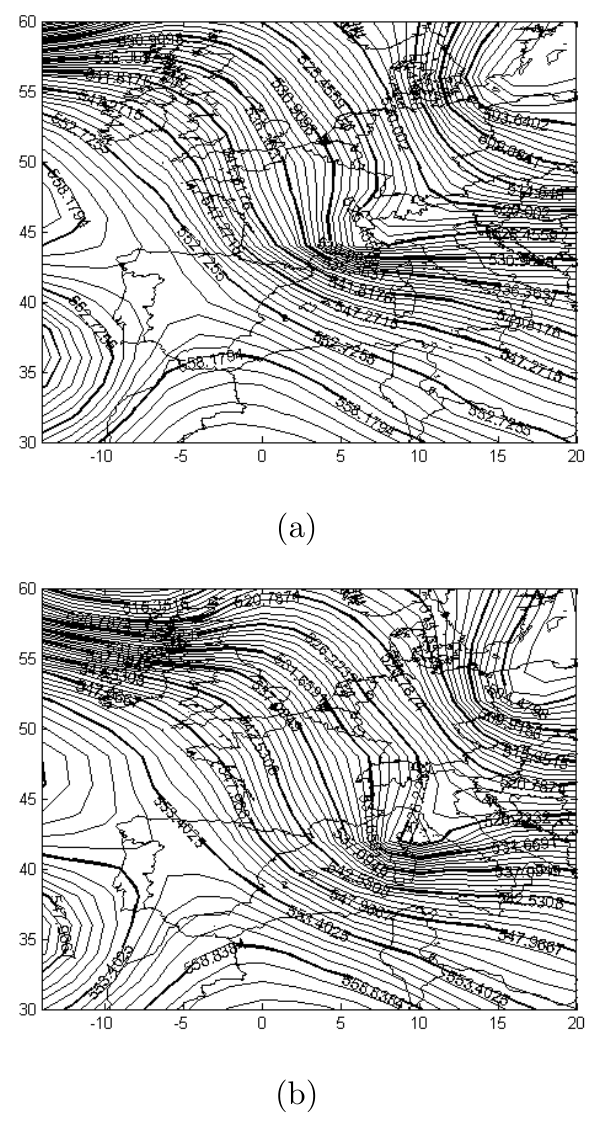
Fig. 2. 500hPa geopotential over Europe obtained from ECMWF analysis at 12:00UTC (a) and 18:00UTC (b) on the 24 March 2009.